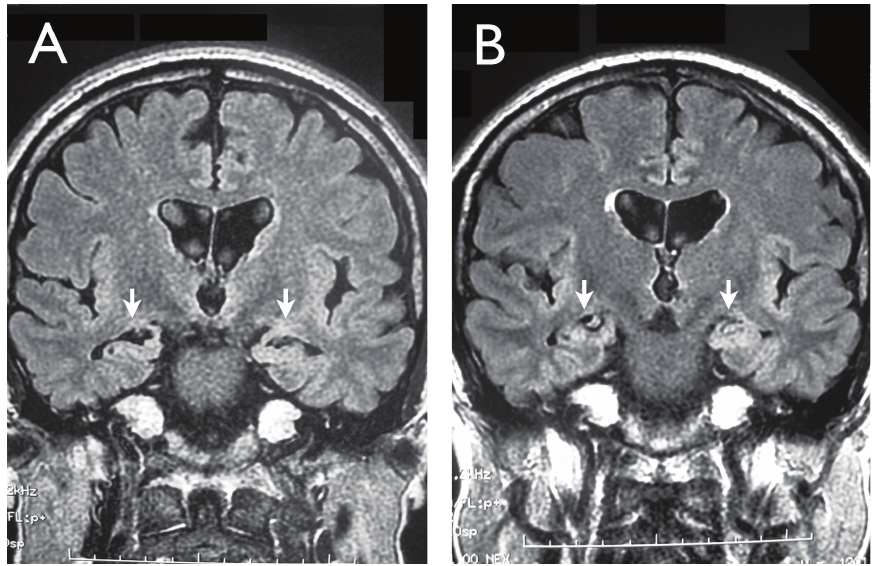
Figure 2: Fluid-attenuated inversion recovery MRI images of the brain in Case 2. MRIs were performed (A) in December 2008 and (B) November 2011. Arrows indicate the